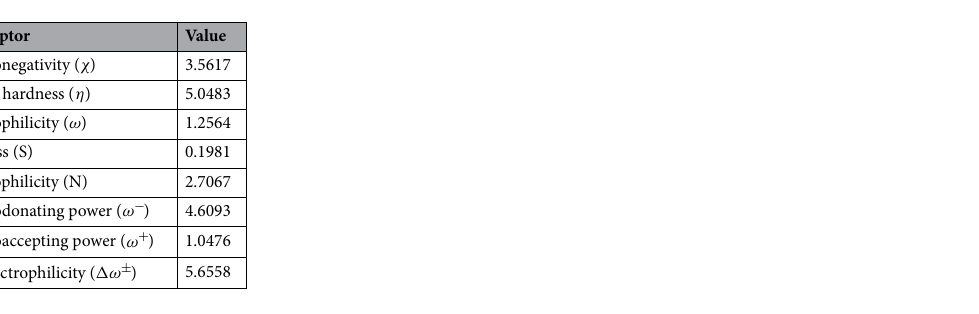
Table 5. Global reactivity descriptors for the Aspergillipeptide D marine cyclopentapeptide (all in eV, with the 1 exception of softness, eV −